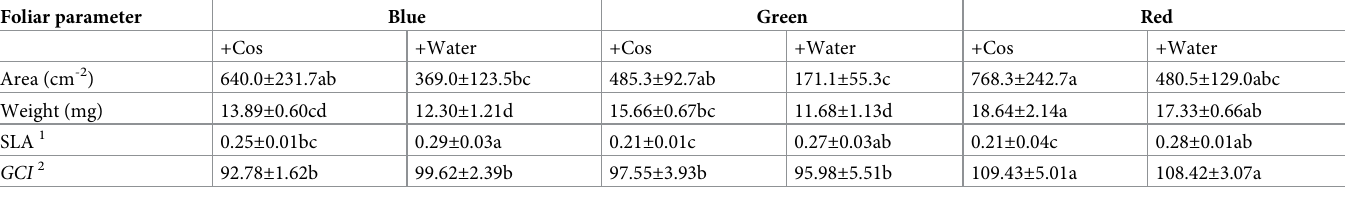
receiving water spray in spectra of blue and green lights (Fig 6E). Finally, the whole-plant P content was highest in water-treated seedlings subjected to the spectrum of red light relative to those exposed to the spectra of blue and green lights (Fig 6F).